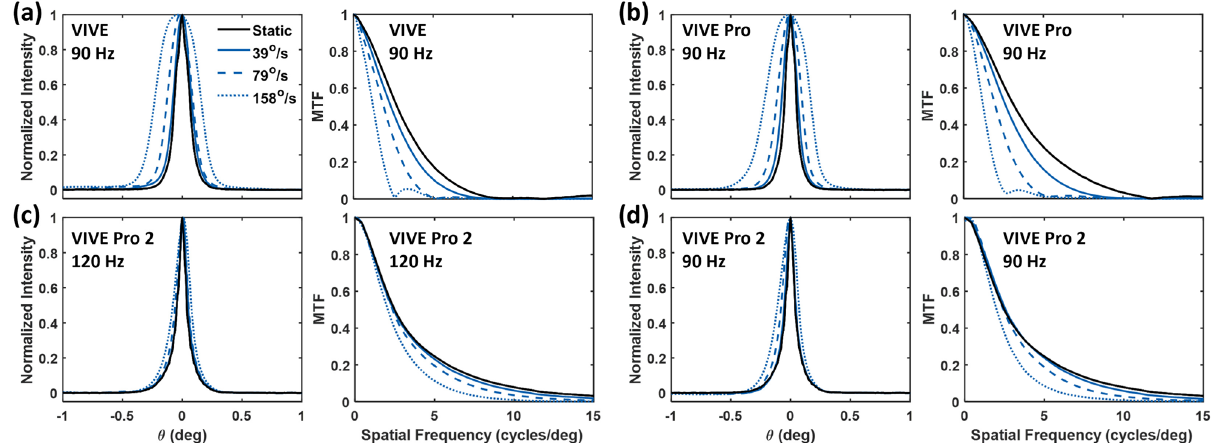
Figure 8. Simulated static and dynamic LSFs and MTFs for ( a ) the VIVE at 90 Hz, ( b ) the VIVE Pro at 90 Hz, ( c ) the VIVE Pro 2 at 120 Hz, and ( d ) the VIVE Pro 2 at 90 Hz during a smooth-pursuit eye movement.